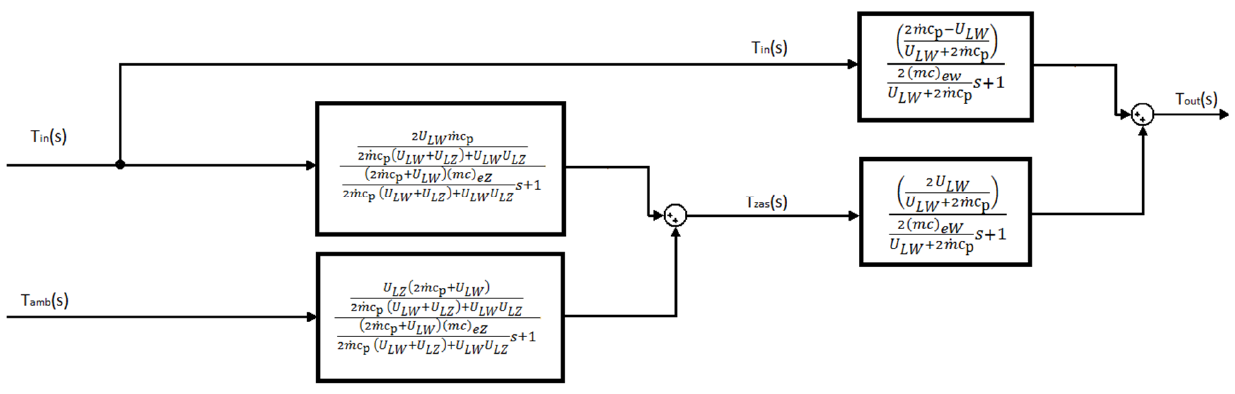
Figure 3. Block diagram of the DHW storage tank.